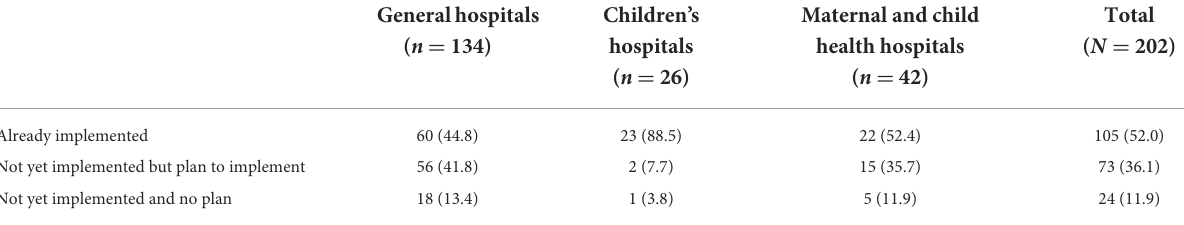
TABLE 1 The status of planning and implementation of rehabilitation for critically ill children.